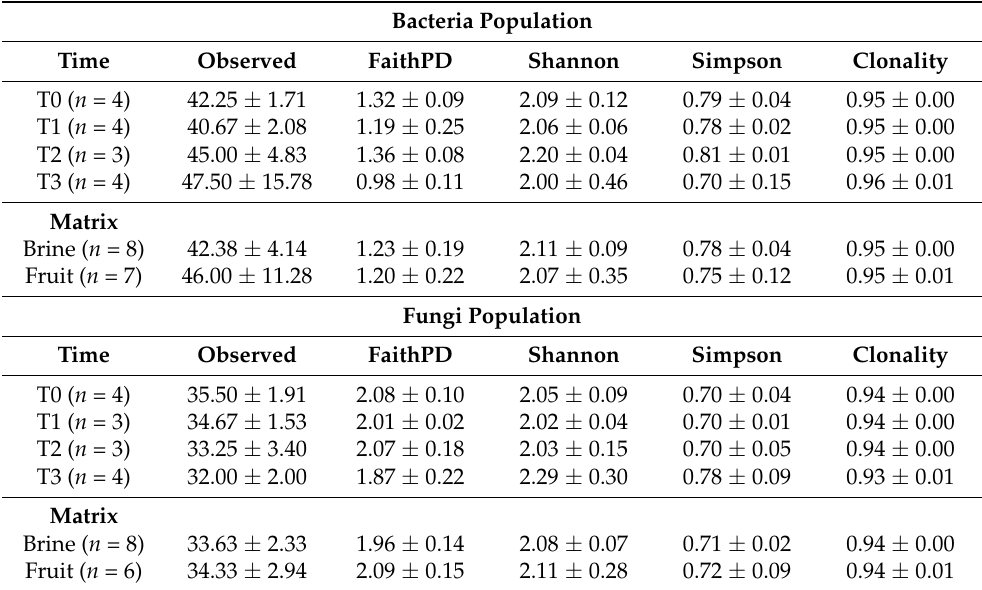
Table 1. Global alpha diversity indexes for bacteria (16S) and fungi (ITS) populations obtained from traditional packed Aloreña de Málaga table olives. Data are expressed as a mean ± the standard deviation of the values through time (T = 0 day, T1 = 42 days, T2 = 130 days, and T3 = 260 days) and olive ecosystem (brine and fruit). For bacteria of fungi populations, no significant differences were noticed between sampling times or olive ecosystems.